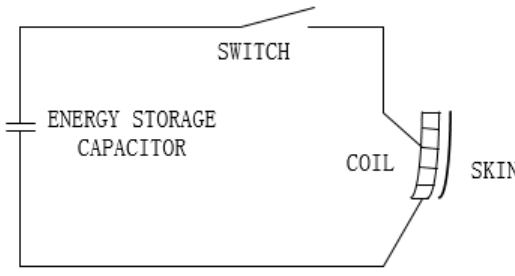
Figure 1. Electro-impulse system basic circuit.